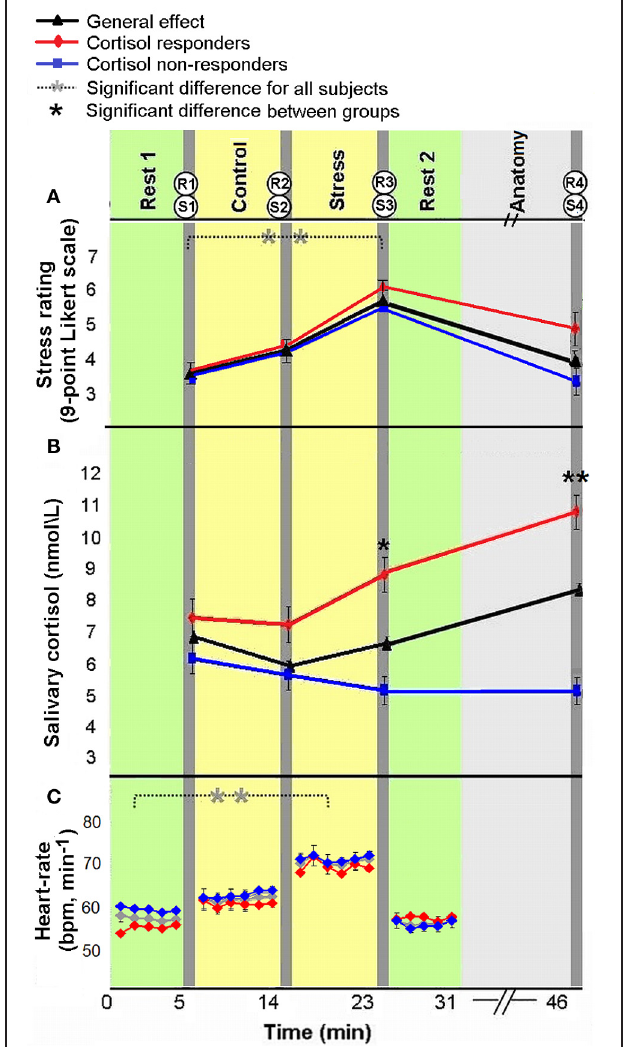
FIGURE 2 | Physiological and psychological response to stress. Subjective ratings of stress (A) , average salivary-cortisol level (B) , and heart rate (HR, bpm) (C) presented in reference to the time course of the experiment. Time 0 indicates the start of experiment. The yellow columns represent control and stress tasks (6min each), green columns represent “rest” conditions (fixation, open eyes, 5min) and light gray column represents an anatomical scan (15min). Between scans (dark gray columns), behavioral rating of stress [R(1–4)] and salivary-cortisol samples [S(1–4)] were taken. HR was continuously recorded. The error bars indicate standard error. ∗ p < 0 . 05, ∗∗ p < 0 .